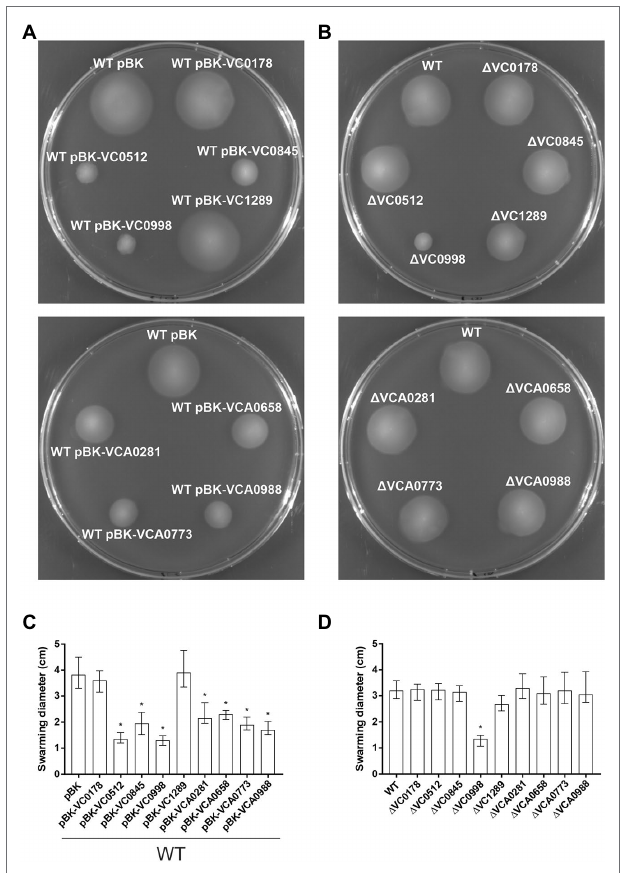
FIGURE 7 | Swimming behavior of constitutive ibr gene (over)-expression strains and deletion mutants. Shown are representative swimming phenotypes of WT with empty vector (pBK) and WT with expression plasmids (A) , as well as of WT and deletion mutants (B) of respective ibr genes, as indicated, on swim agar plates. The swimming diameters of 16 independent assays for each strain are compiled in the bar chart presented as median ± IQR (C,D) . Significant differences between WT pBK and WT with expression plasmids, or between WT and deletion mutants, are indicated by an asterisk (* p < 0.001 Kruskal–Wallis test followed by post hoc Dunn’s multiple